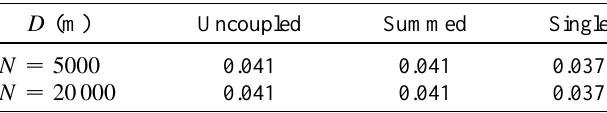
TABLE II. Dynamic aperture values relative to the uncoupled Hénon map and after the summed- and single-resonance compensations. The associated error [according to the formula (34)] is about 2% for N (cid:1) 5000 and about 4% for N (cid:1) 20 000 . D (m) Uncoupled Summed Single N (cid:1) 5000 0.041 0.041 0.037 N (cid:1) 20 000 0.041